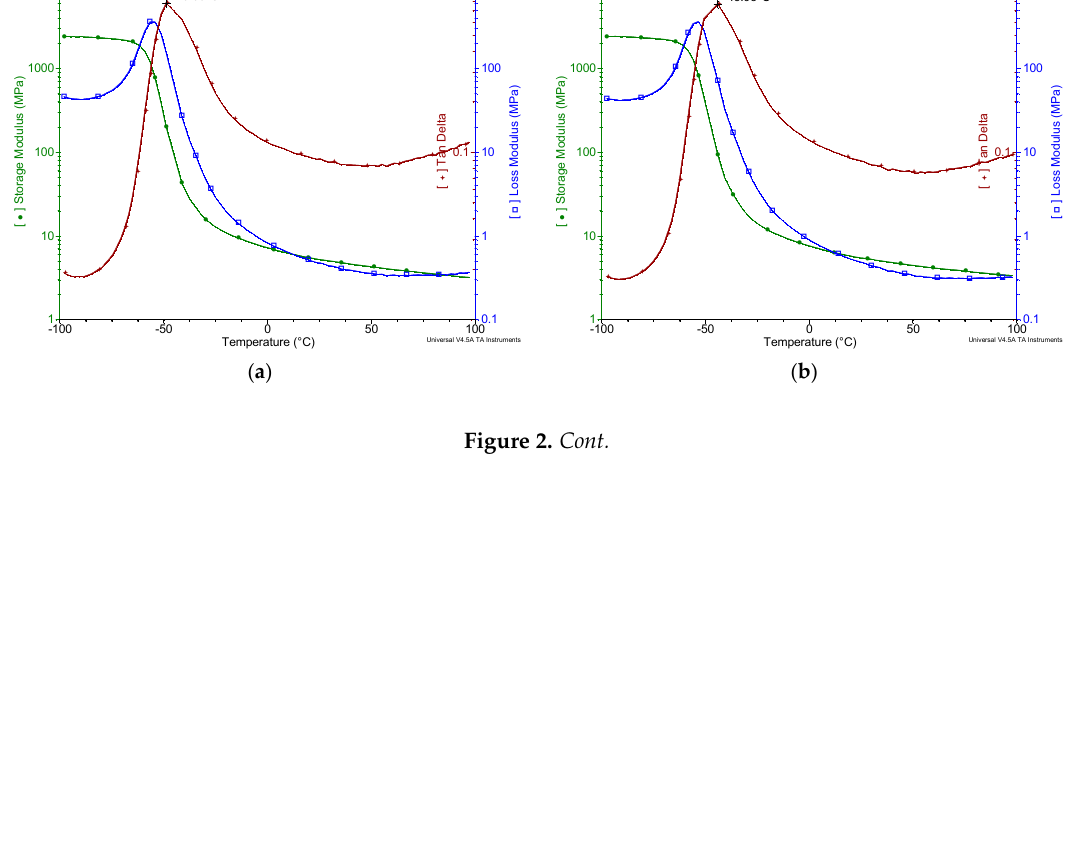
Figure 2. Dynamic mechanical analysis (DMA) results for various excitation frequencies: ( a ) 1 Hz, ( b ) 2 Hz, ( c ) 5 Hz, and ( d ) 10 Hz.